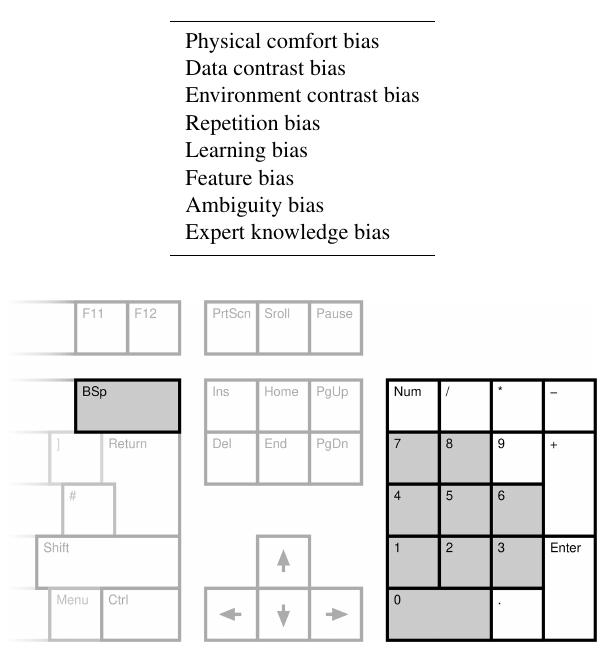
Figure 2. The original right-hand key set for classification. The grey-shaded keys were used for the classification.